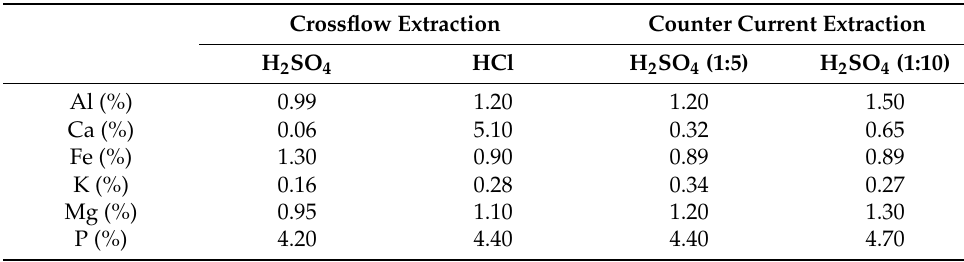
Table 2. Elements constituting the extracts obtained with the different extraction procedures (extrac- tion time: 4 h). The analysis was performed by ICP-OES. Crossflow